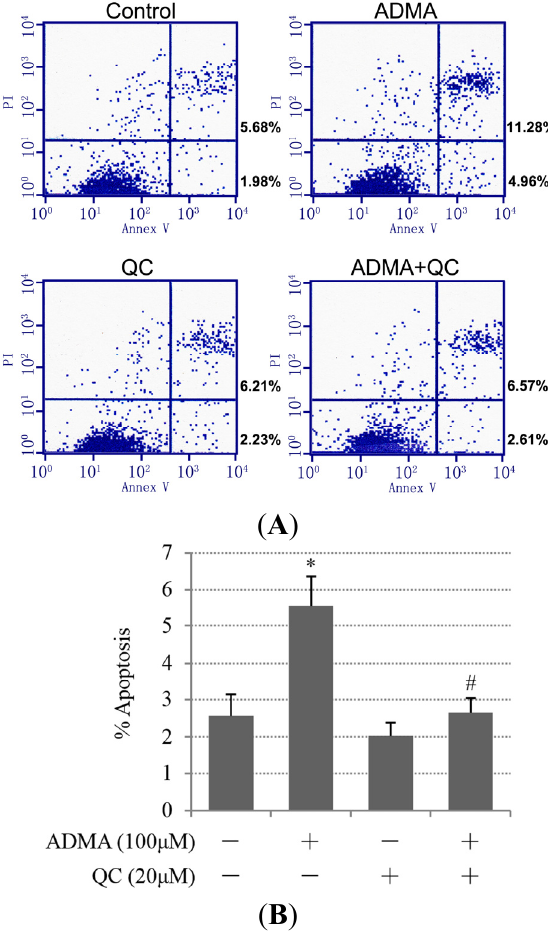
Figure 4. Quercetin (QC) inhibited ADMA-induced apoptosis. GEnCs were treated for 1 h in the presence or absence of 20 μ M QC. Cells were then incubated with 100 μ M ADMA for 24 h. Apoptosis was assessed by flow cytometry. Data showed one representative experiment ( A ) or the mean SD of three independent experiments ( B ). p < 0.05 by ANOVA was considered significant. * different from controls ( p < 0.05); # different from ADMA-stimulated controls ( p <